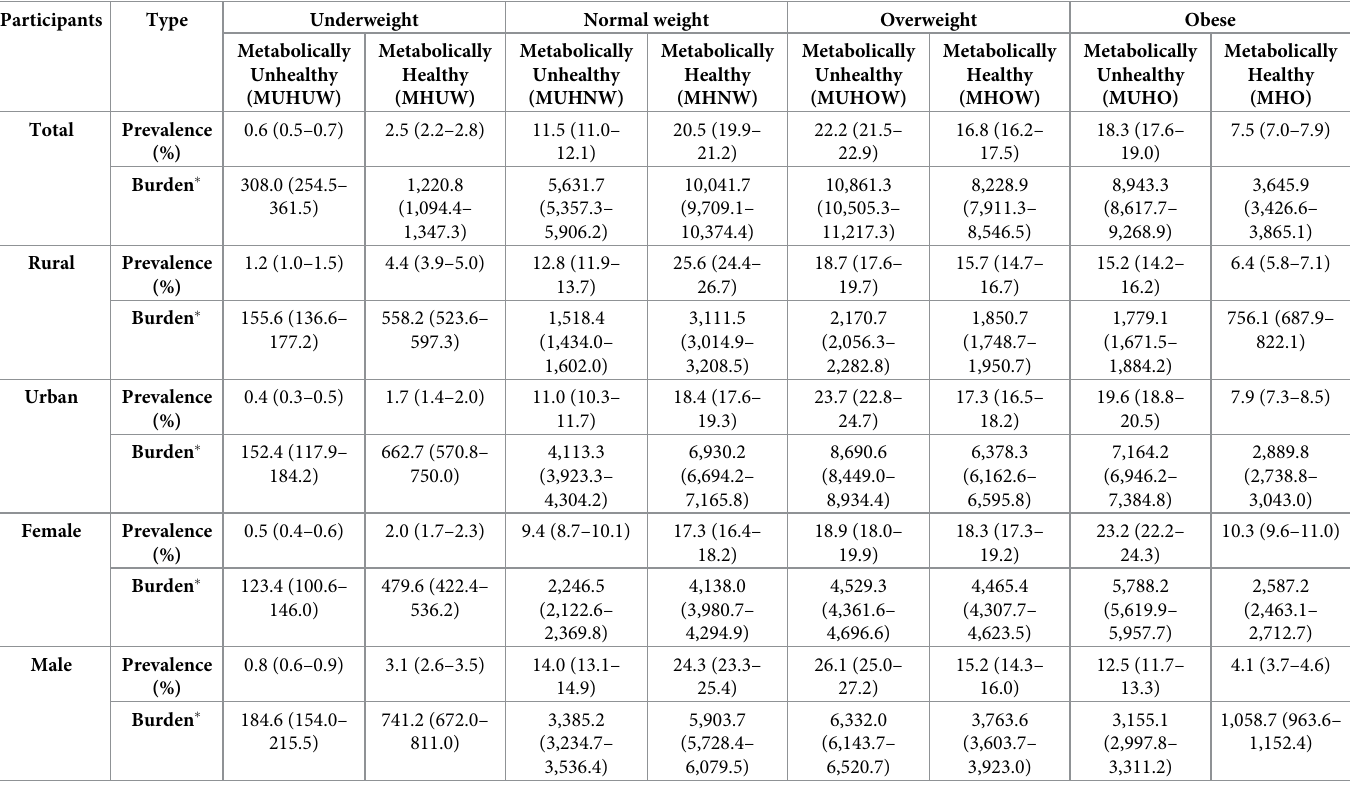
Table 2. Comparison of burden and prevalence of metabolic unhealthiness/healthiness among Iranian adults of different body size phenotype (for all ages) based on their living area (rural vs urban) and